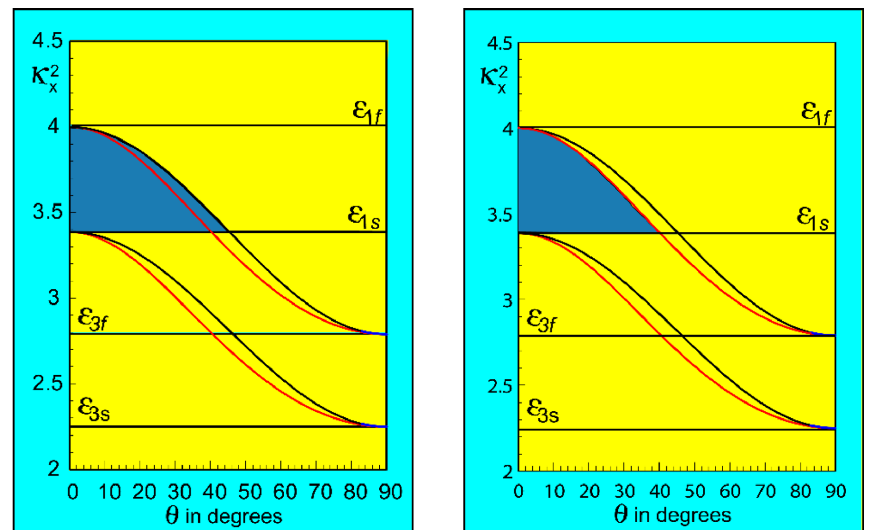
Figure 4. The change in the regions defining pure hybrid homogeneous waves for the anisotropic guide with all-positive diagonal tensor elements as the angles of orientation are changed. Values used: e 1 s = 3.3856, e 3 s = 2.25, e 1 f = 4 and e 3 f = 2.7889. The blue areas show how changing the value of / from / = 0 (cid:3) (the blue curves) to / = 90 (cid:3) (the red curves) has little effect on the range of h over which pure hybrid homogeneous modes are